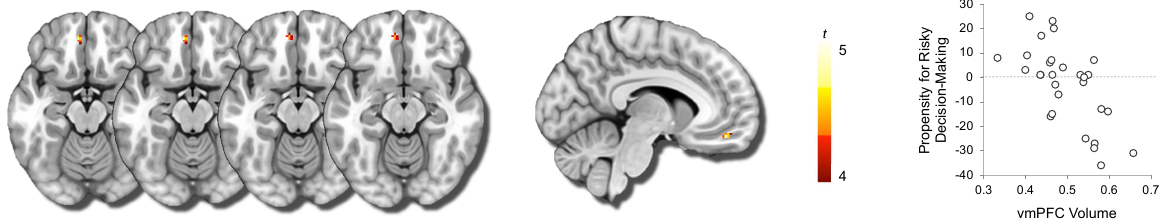
Figure 3. VBM results showing vmPFC voxels that showed negative correlation with the behavioral propensity for engaging in high-stakes gambling. Red–yellow areas highlight voxels that were significant using the TFCE method. Scatterplot is provided for visualization purposes